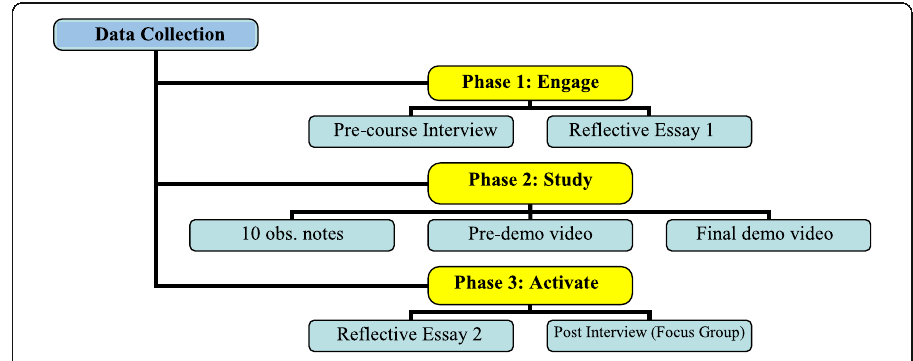
Fig. 2 A schematic representation of the data collection